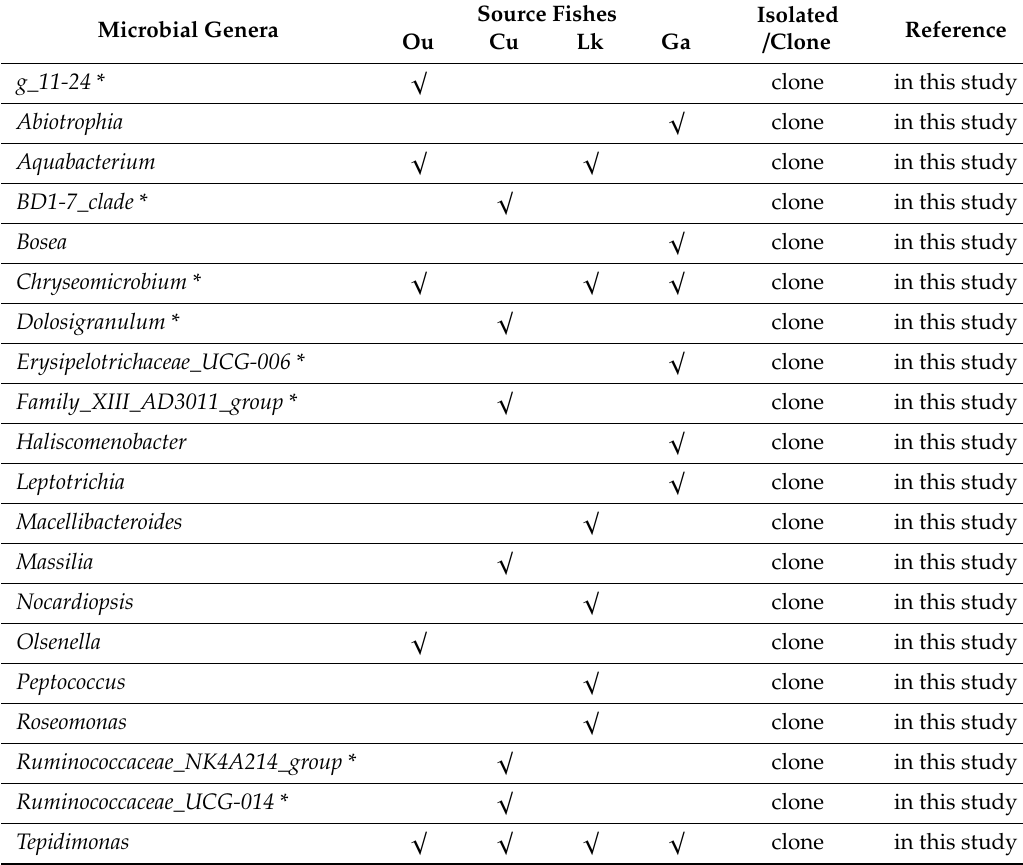
Table 3. Summary of new reports for gut microbiota in marine